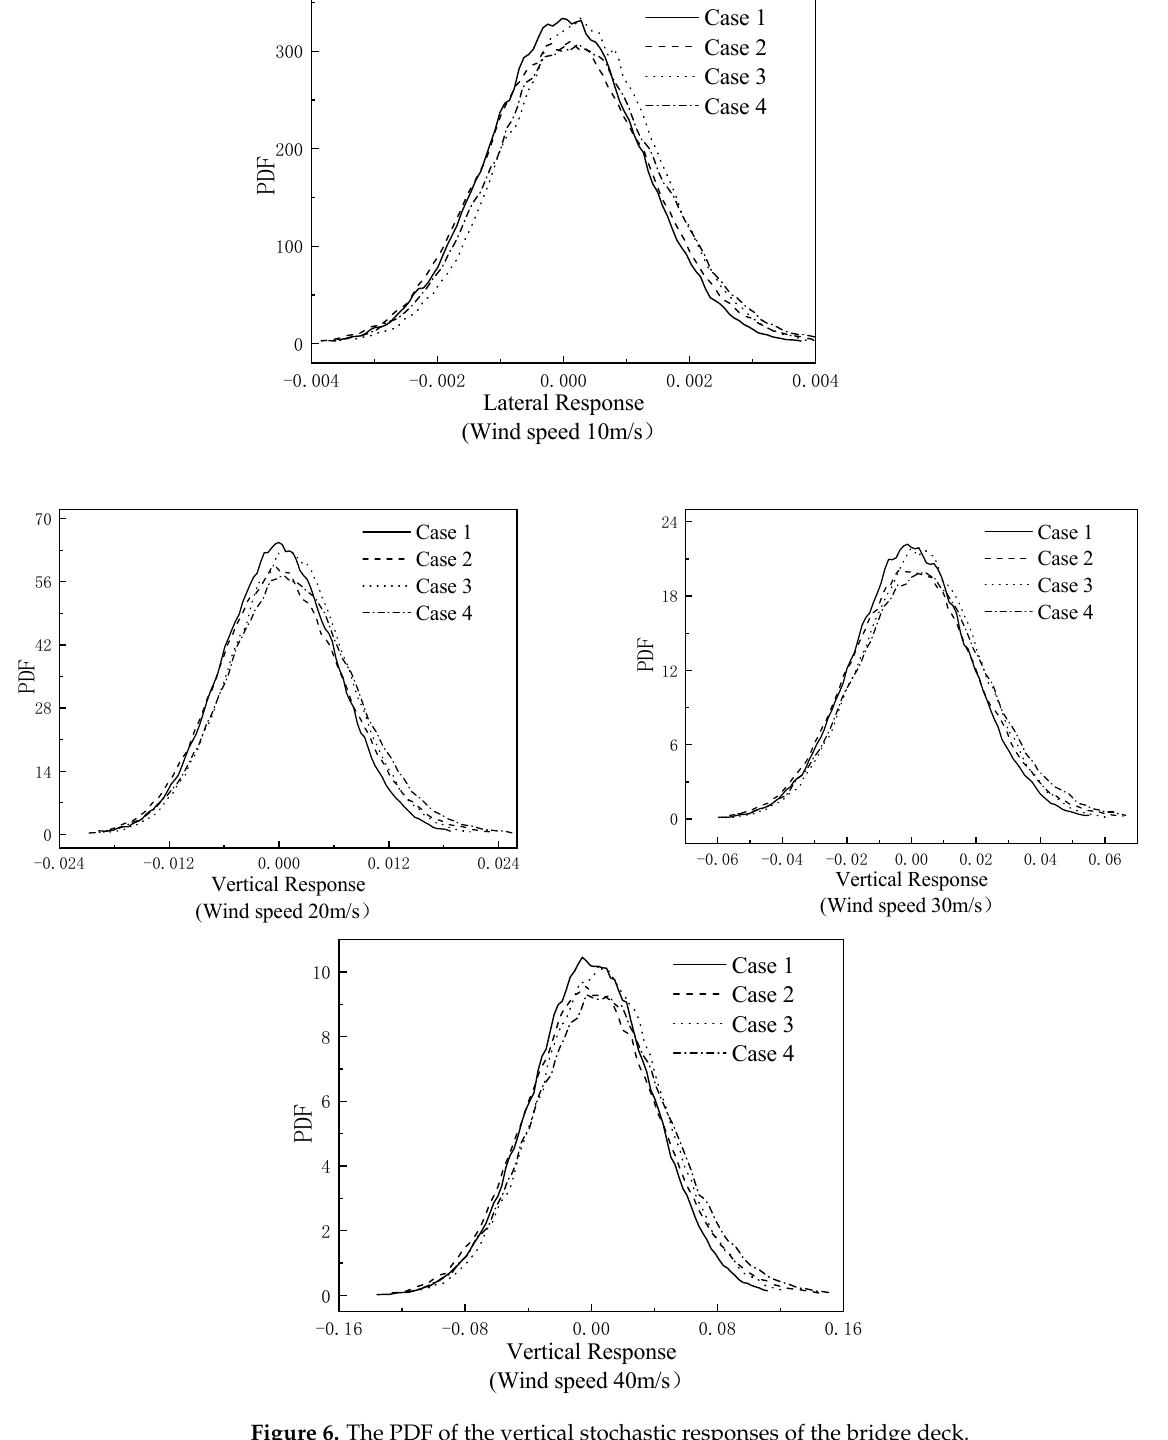
Figure 6. The PDF of the vertical stochastic responses of the bridge deck.